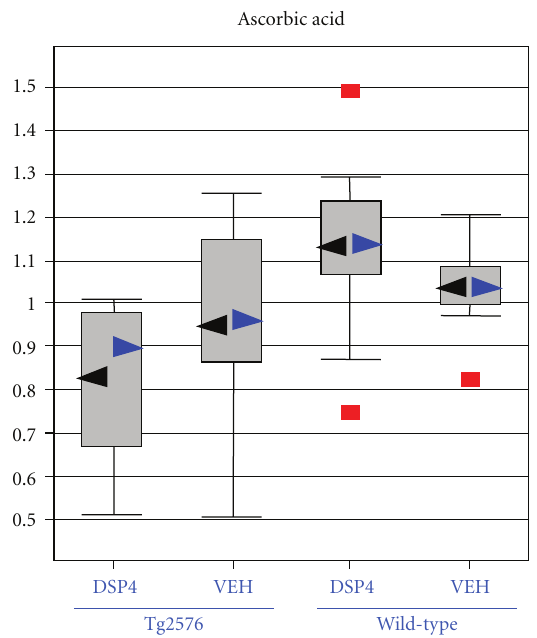
Figure 4: Ascorbic acid, another marker of oxidative stress. Box plots for levels of ascorbic acid in the brain, displaying the distribution of values within each of the four cohorts represented as a Whisker plot, with the relative normalized intensity as the abscissa. Mean values represented by the black arrowheads, median values by blue arrowheads. Detailed statistical comparisons of ascorbate in the four cohorts are given in Table